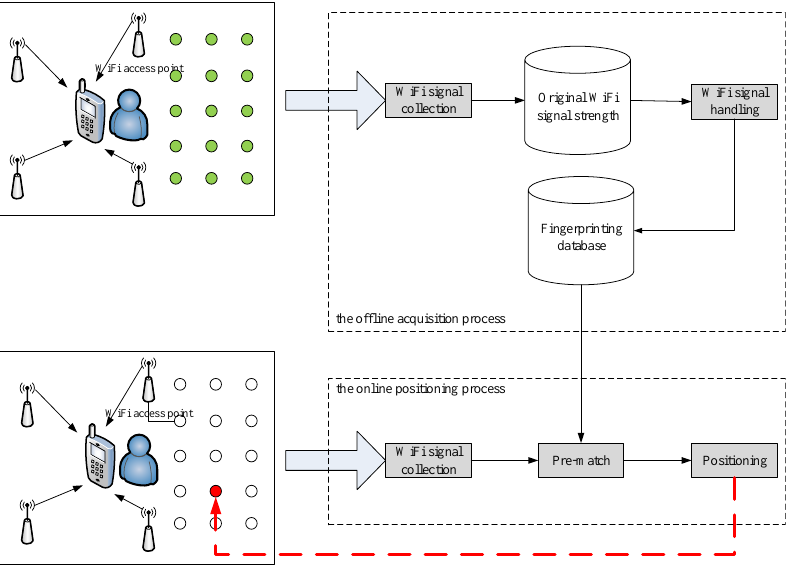
Figure 1. Methodology of proposed